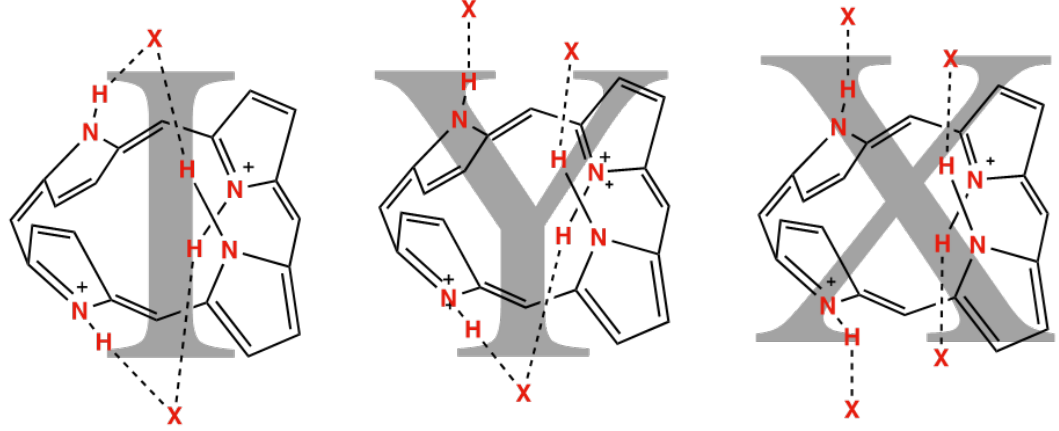
Figure 3. “I”, “Y”, and “X” shapes adopted by porphyrin dications interacting with two, three, and four atoms, respectively. Table 2. The H-bonding distances D ⋯ A of the core atoms in the discussed crystal structures.